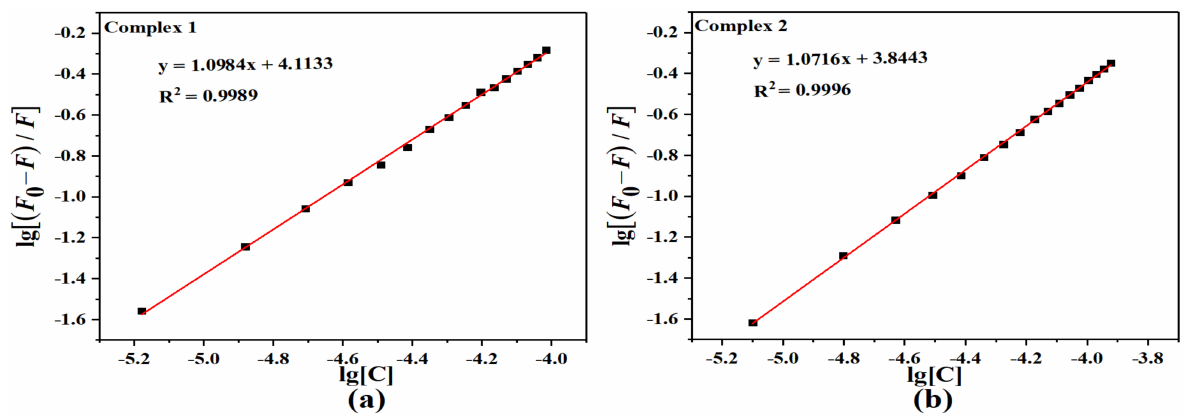
Figure 4. Double-log plots of DNA fluorescence quenching by complex 1 ( a ) and complex 2 ( b ).